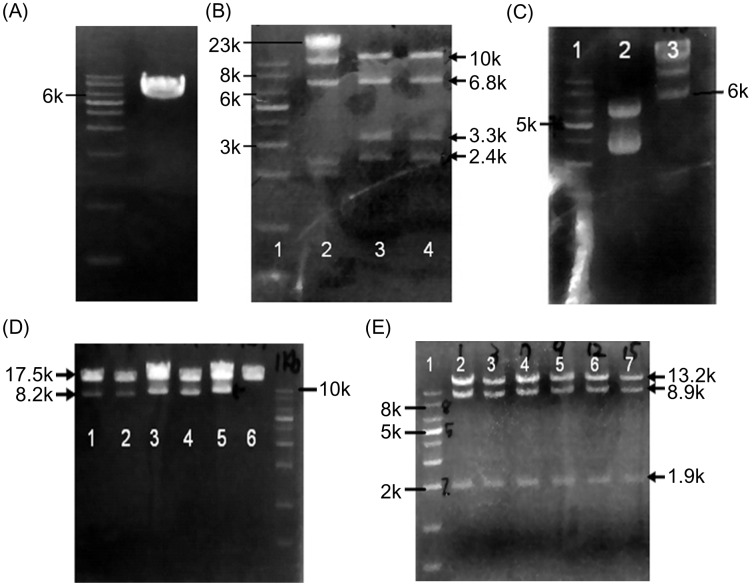
Electrophorogram of the targeting vectors.(A) Retrieved pL253 with homology arms, about 6.1 kb. (B) Retrieved A with about 17.7 kb. Lane 1: 1 kb marker; Lane 2: λ HindIII marker; Lane 3 and 4: retrieved A digested with KpnI. (C) The pL452 with homology arms. Lane 1: 1 kb marker; Lane 2: pL452 with homology arms, about 5.4 kb (supercoid and linear form); Lane 3: λ HindIII marker. (D) First loxP site insertion Lane 1–5: retrieved A + vector C digested with SpelI; Lane 6: retrieved A + vector C; Last lane: 1kb marker. (E) Lane 1: 1kb marker; Lane 2–7: excision of Neo cassette and digested with XhoI.